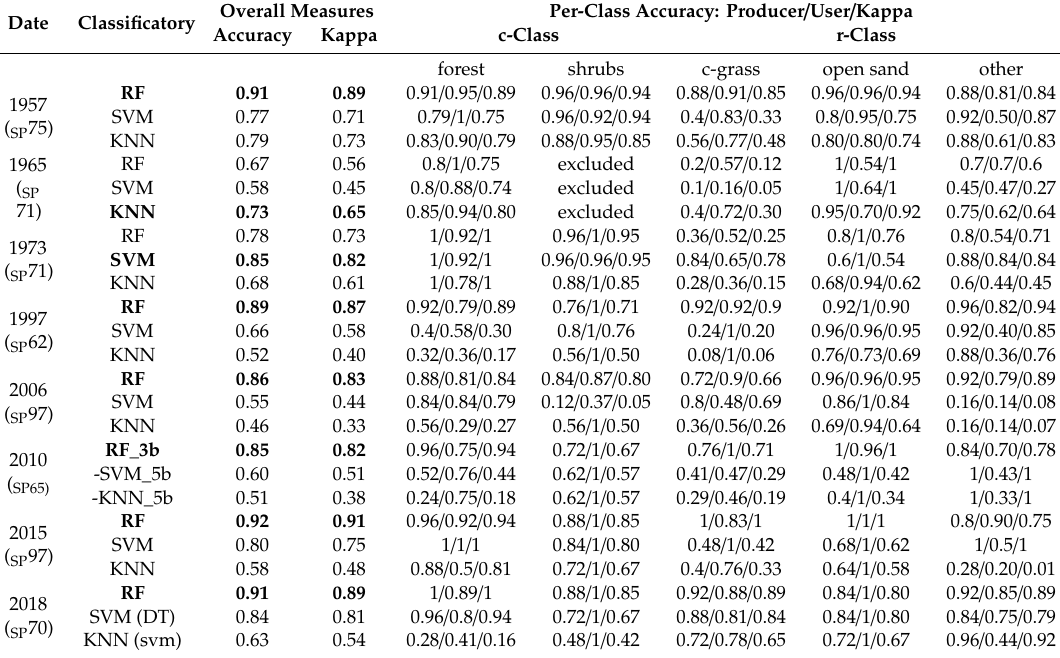
Table A3. The accuracy assessment table. The best performing classifier overall for each time period